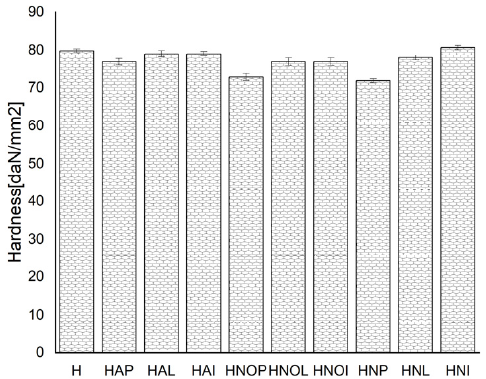
Figure 3. Evolution of elongation values of the experimental 5083 alloy samples, in different struc- tural states.